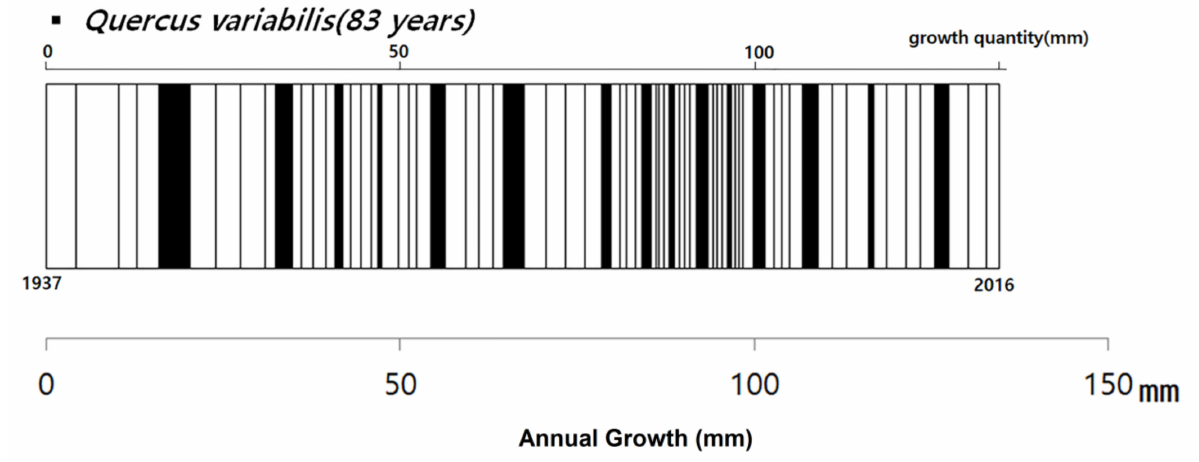
Figure 4. Tree age and growth of the Quercus serrata sample tree in fixed survey plot no. 20 in the forest of the Changdeok- gung Rear Garden. Black line in the figure shows the annual ring of the late wood. Table 9. Changes in species diversity index of the fixed survey plots of the forest of the Changdeokgung Rear Garden (1998–2018) (unit area: 100 m 2 ).